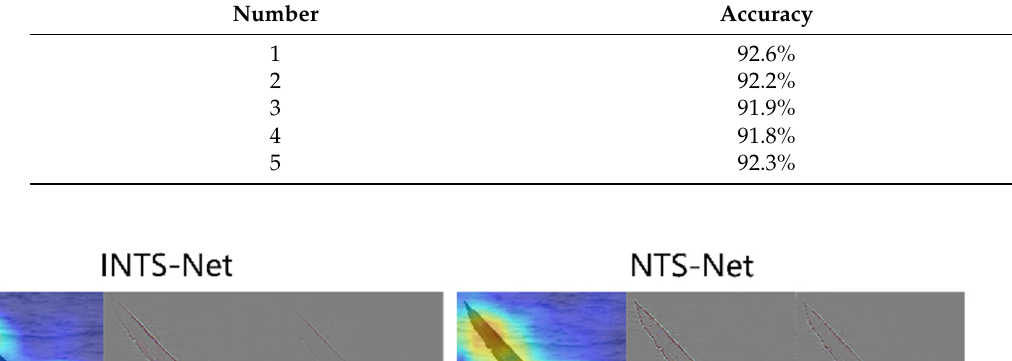
Figure 5. The curves of loss value changes of NTS-Net and INTS-Net on the CUB_200_2011 data set after 140 rounds of training. Table 3. Repeated Experimental of INTS-Net on CUB-200-2011 dataset. Table 2. Comparisons on CUB-200-2011 dataset. * refers to the model we reproduce.